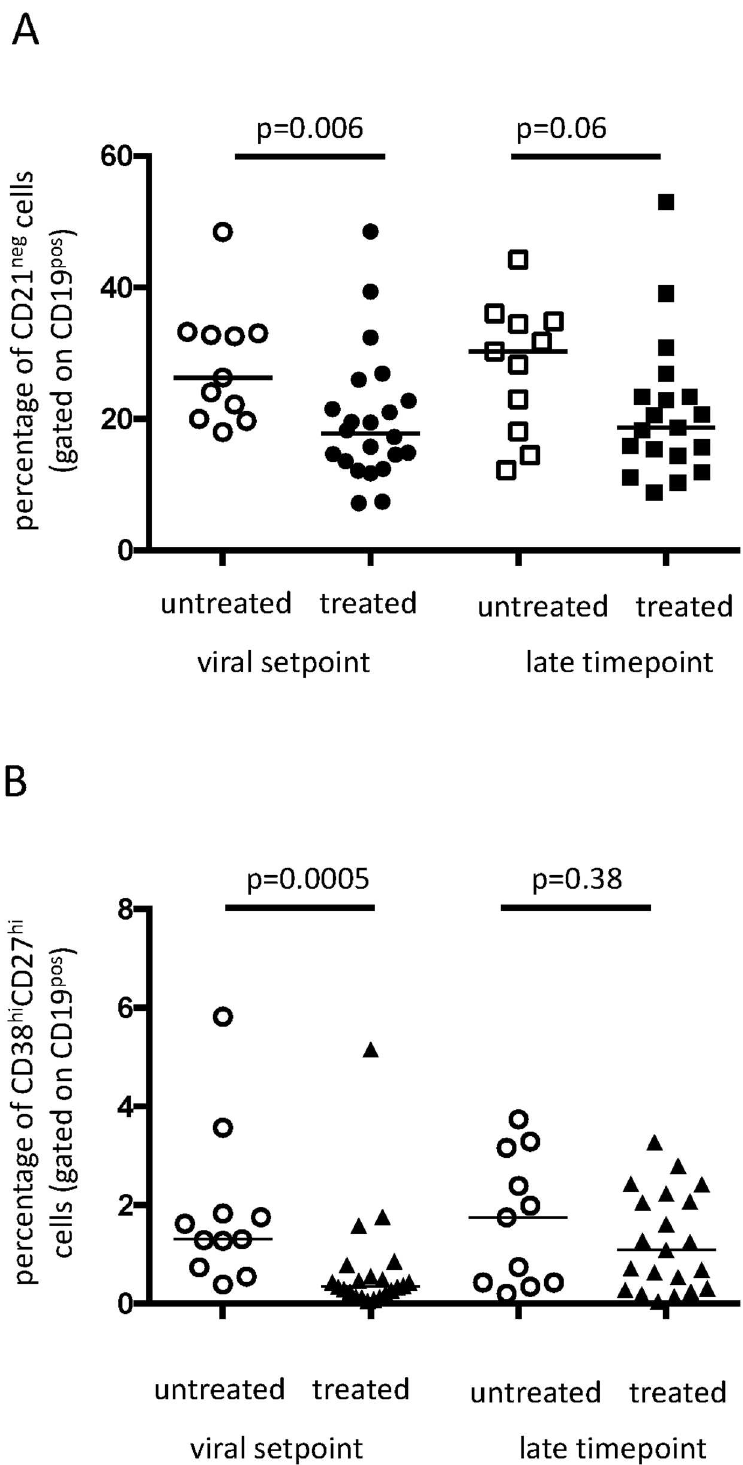
Fig 2. Treated patients show A: a smaller fraction of antigen-primed, CD21 neg , B cells at viral setpoint as well as B: a smaller fraction of plasmablasts at viral setpoint. Horizontalbars representmedian values and statistical significancewas calculatedusing the nonparametric Mann-Whitney U